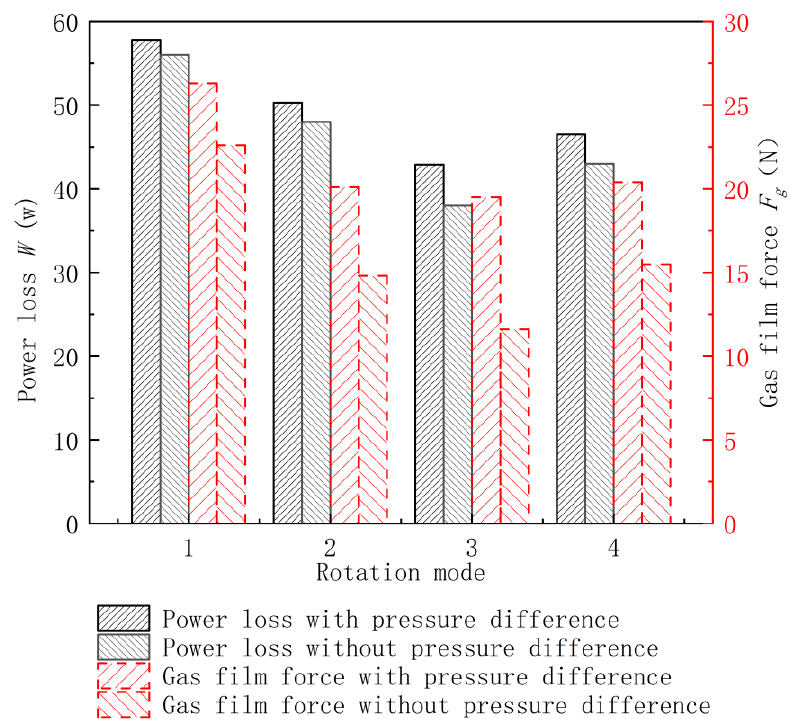
Figure 9. The influence of four rotating modes on sealing performance.